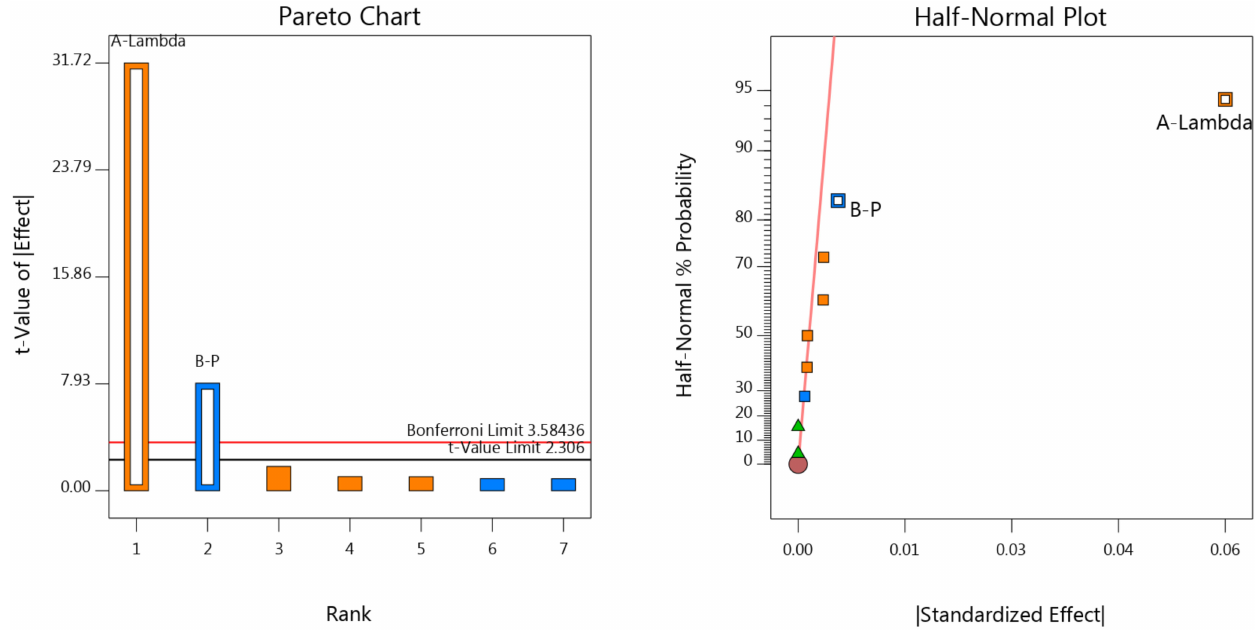
Figure 5. Pareto chart and half-normal plot for A IMP5_LOQ ( left ) and A IMP4_SL ( right ),